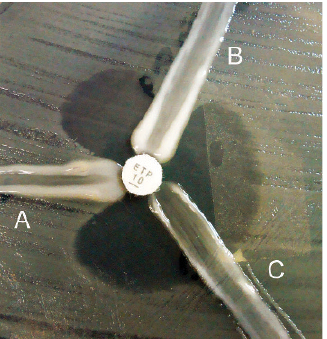
Figure 1 - Modified Hodge test (MHT) with ertapenem disks. Interpretation of the MHT results proposed in this study: A) true- positive MHT, B) inconclusive MHT and C) negative